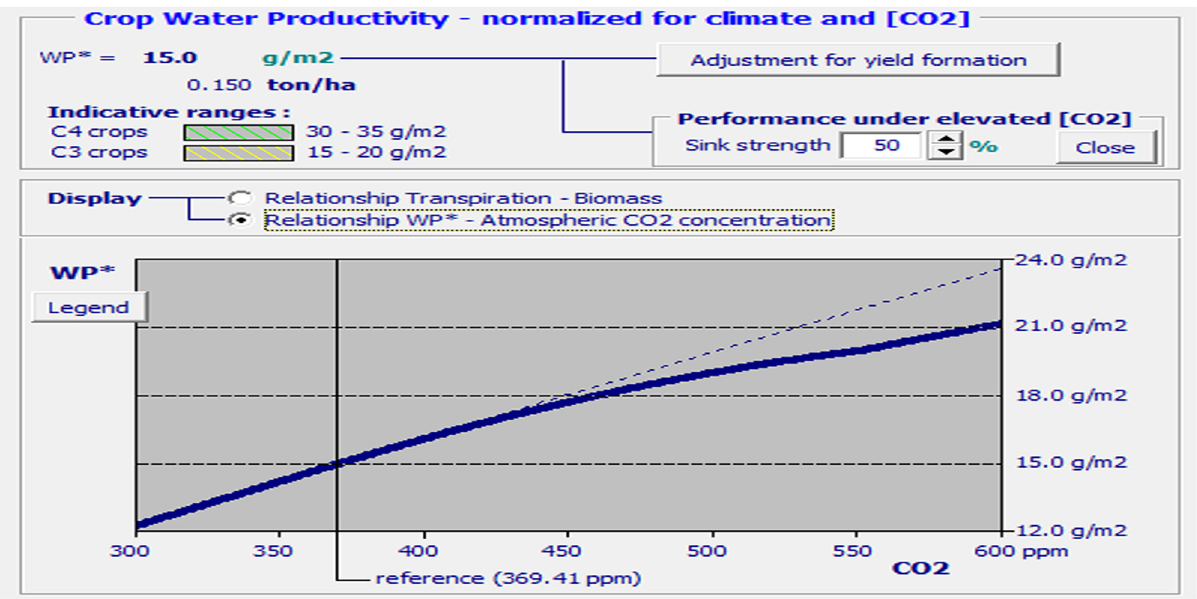
Figure 3: The relationship between wheat, water productivity and CO 2